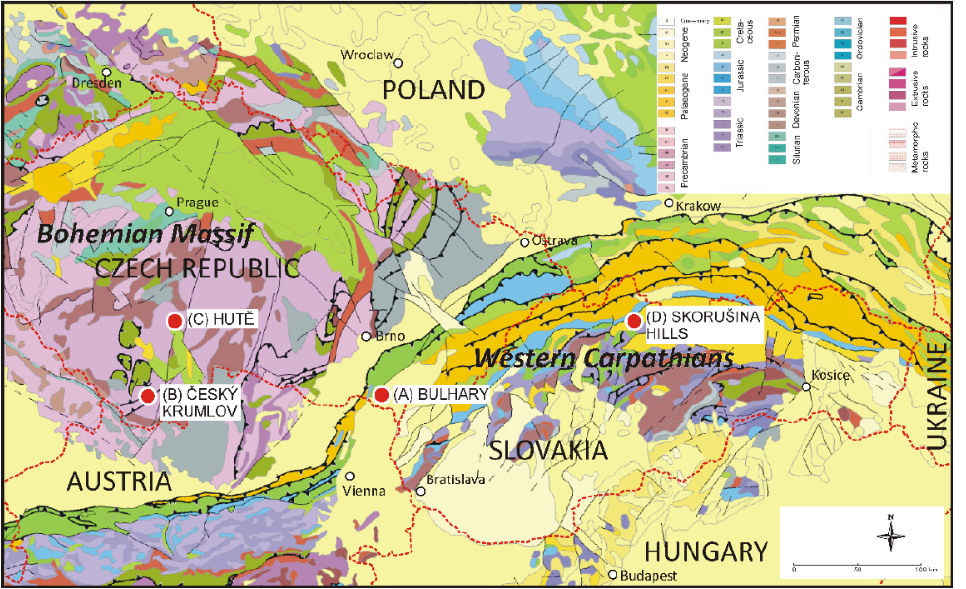
Figure 8. Simplified geological map of Central Europe with study localities indicated. Compiled using EGDI maps.